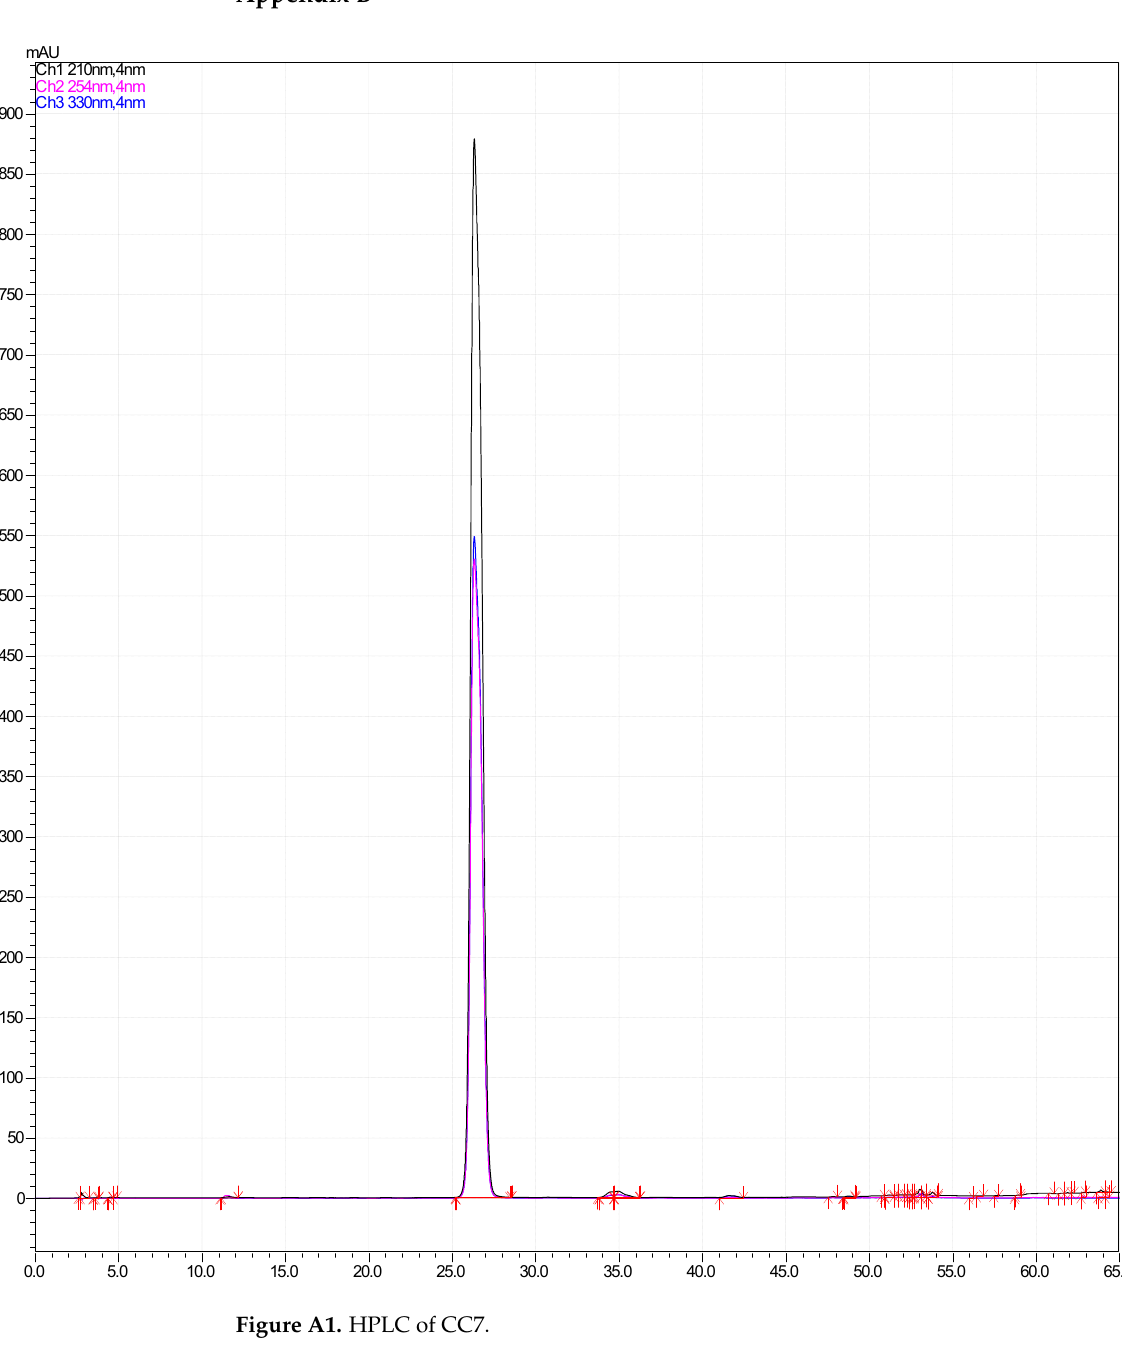
Figure A1. HPLC of CC7.